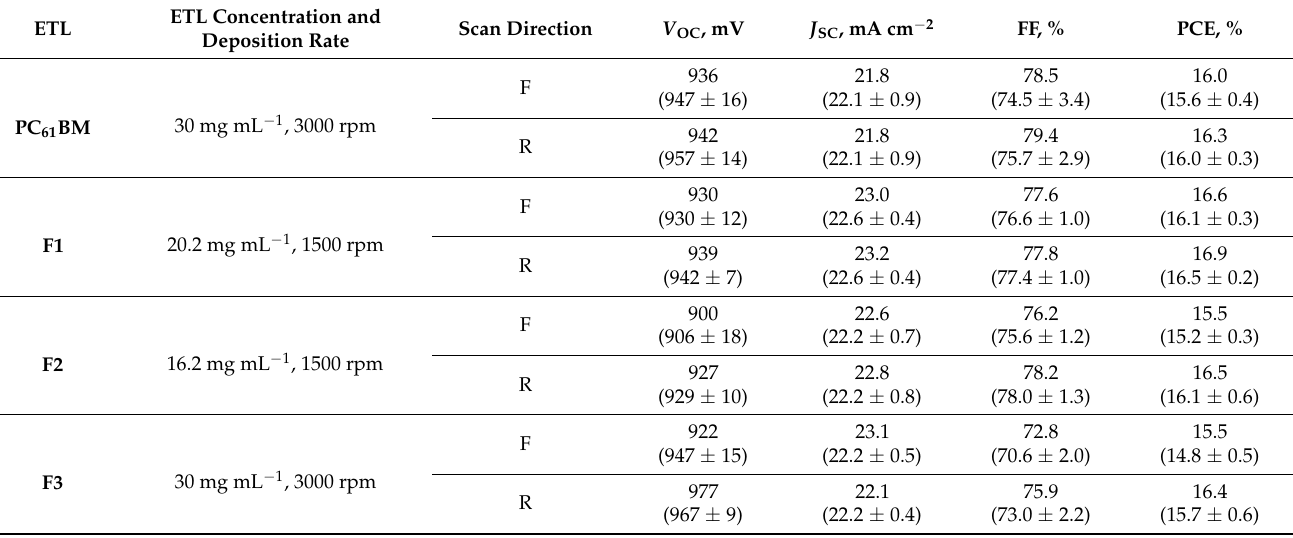
Table 1. Characteristics of perovskite solar cells assembled using different fullerene derivatives as ETL materials *.